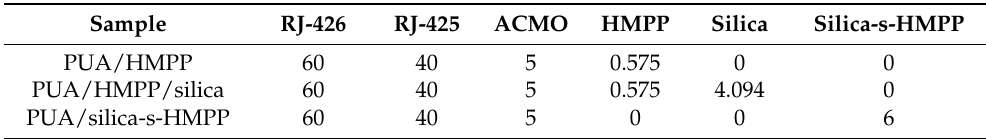
Table 1. Formulas of the UV-cured hybrid materials.